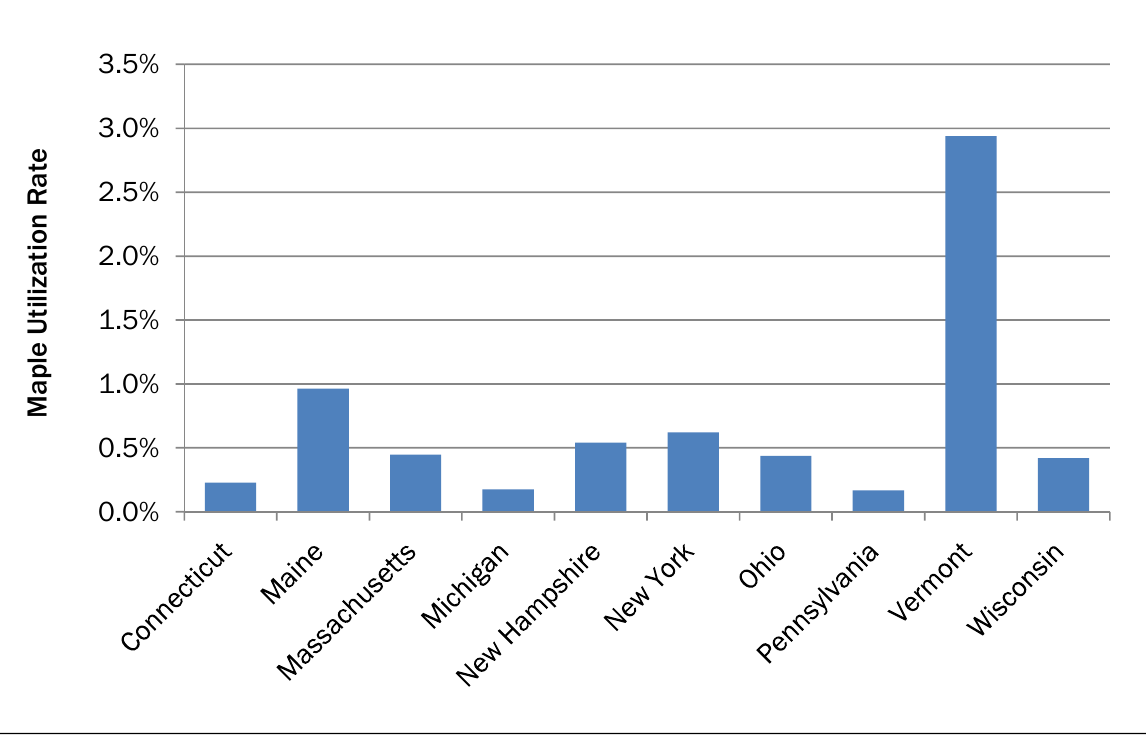
Note: Results based on NASS Maple Syrup Crop Report (2010) and U.S. Foresty Service FIA data (2010) on the number of tappable sugar and red maple